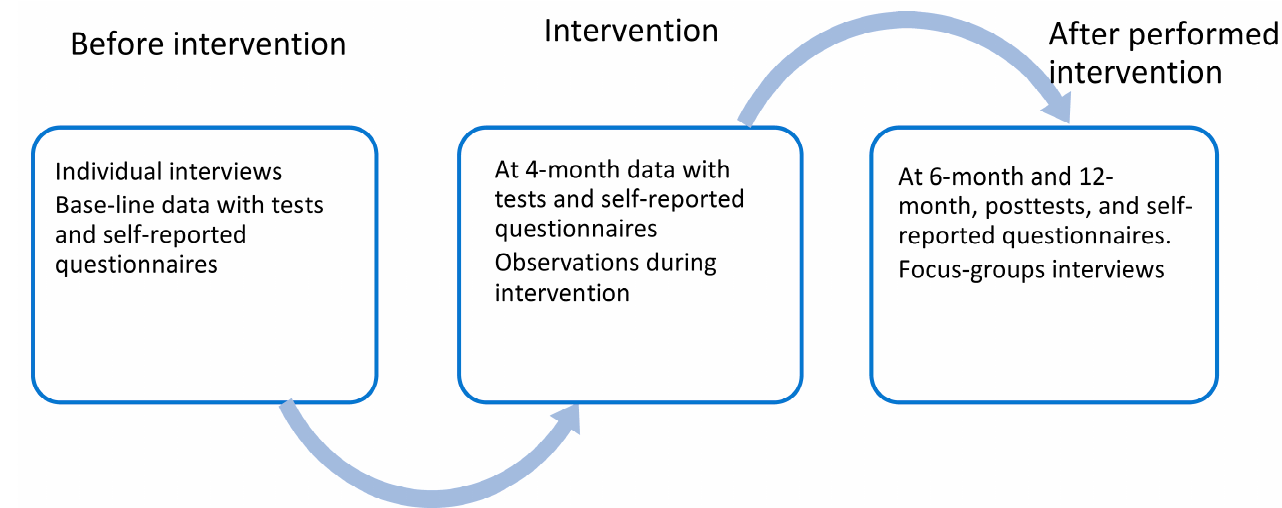
Figure 1. Data collection.